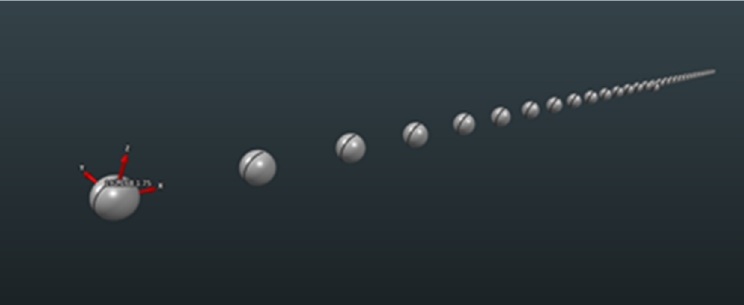
Figure 6. CAD model of ball-bar standard.